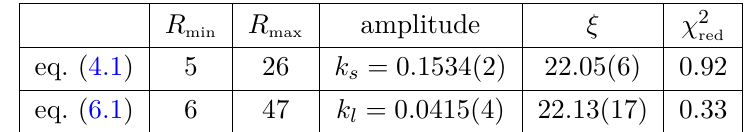
Table 2 . Results of the fits to the short- and long-distance behaviors, according to the Svetitsky- Yaffe mapping, of the Polyakov loop correlator for N to T/T = 0 . 86 c